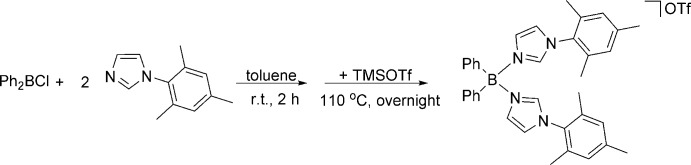
Reaction for the synthesis of Ph2B(MesIm)2OTf. Ph2BCl (1 equiv.), 1-mesityl-1H-imidazole (2 equiv.) were stirred in toluene at room temperature for 2 h. TMS OTf (1 equiv.) was then added and the mixture was further stirred at 383 K overnight.